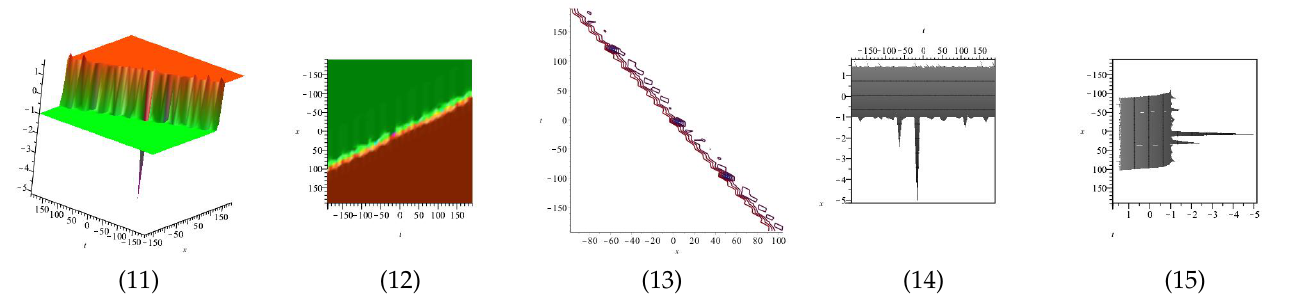
Figure 15. The 3D and 2D with the diagram of the real part of equation u 3,2 , in three different domains, for S 1 = 0.20, S 2 = 0.70, S 3 = − 0.50. ( 2 ) , ( 7 ) , ( 12 ) , ( 4 ) , ( 9 ) , ( 14 ) , and ( 5 ) , ( 10 ) , ( 15 ) display z − axis,